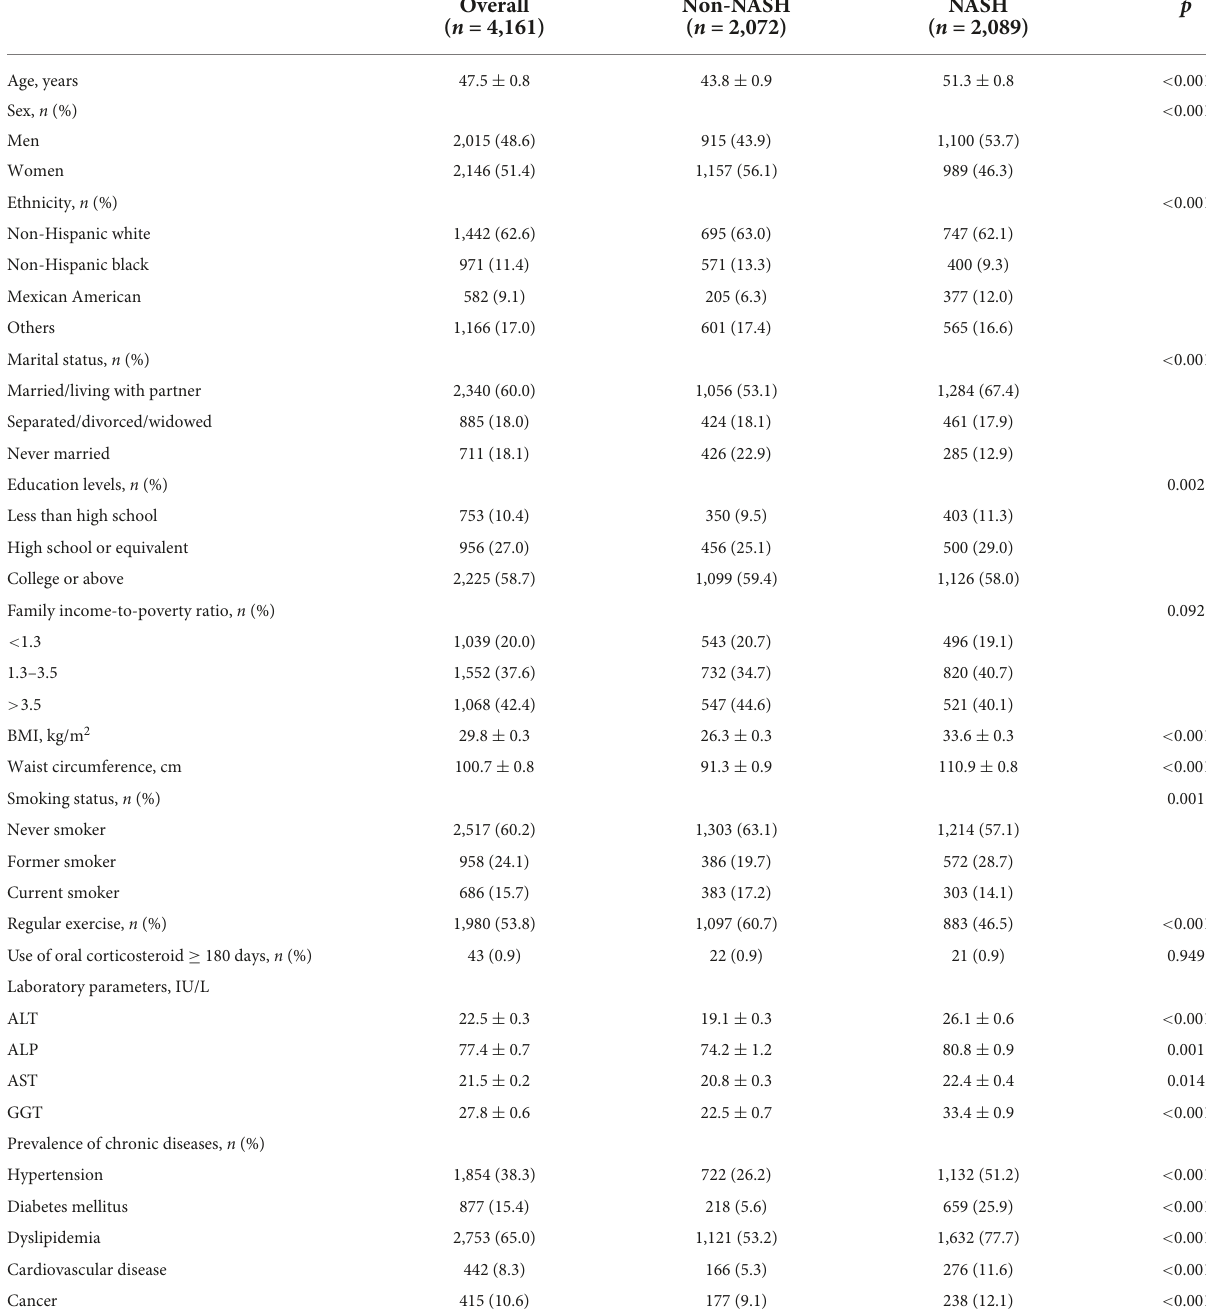
TABLE 1 Basic characteristics of participants of this study.